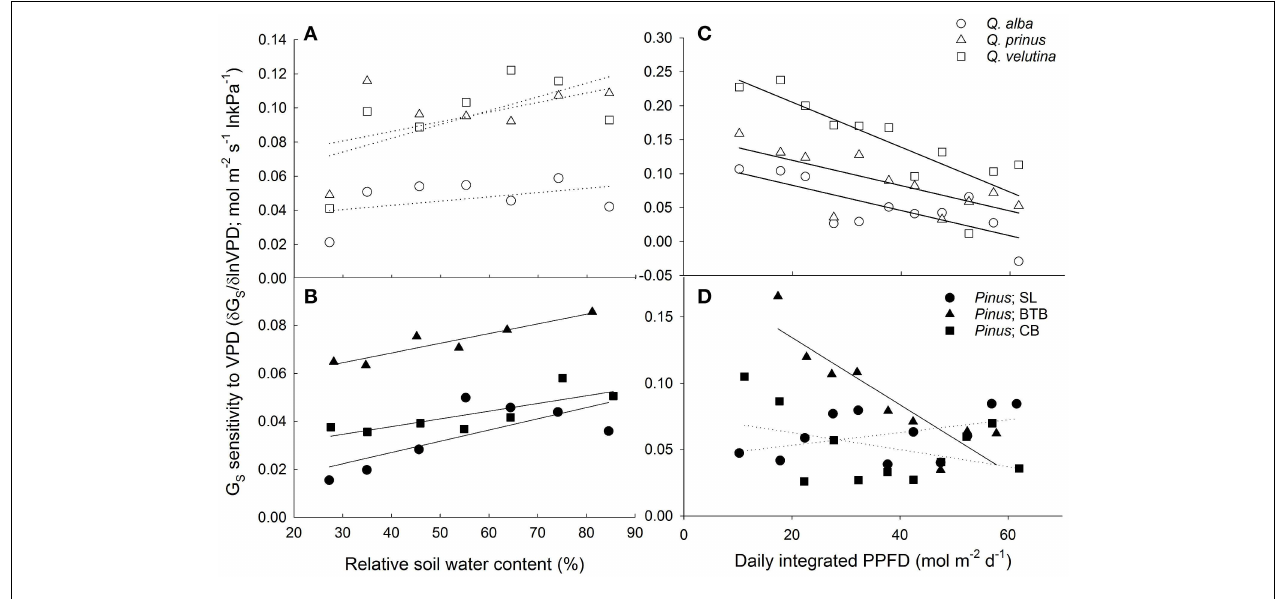
G S sensitivity to VPD vs. daily integrated photosynthetic photon flux density (PPFD; mol photons m − 2 d − 1 ) for (C) oaks including Q. alba ( y = − 0.0019x + 0.12; r 2 = 0 . 59 ), Q. prinus ( y = − 0 . 0019x + 0 . 16 ; r 2 = 0 . 54 ) and Q. velutina ( y = − 0 . 0033x + 0 . 27 ; r 2 = 0 . 71 ) and for (D) pines at the SL site (ns; P = 0 .17), the BTB site ( y = − 0 . 0025x + 0 . 19 ; r 2 = 0 . 8 ) and the CB site (ns; P = 0 .22). Solid lines represent significant relationships (slope P < 0 . 05 ); dotted lines represent non-significant relationships (slope P > 0 . 05